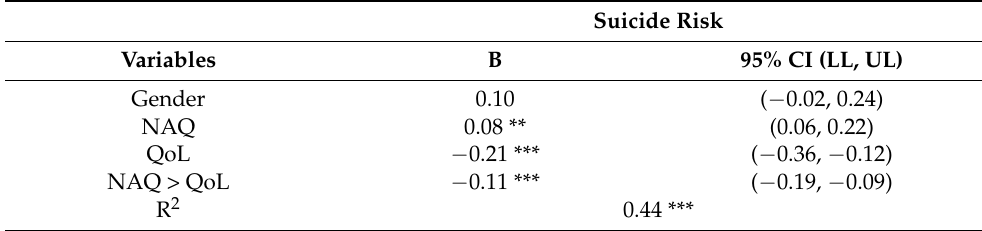
Table 6. Regression models of suicide